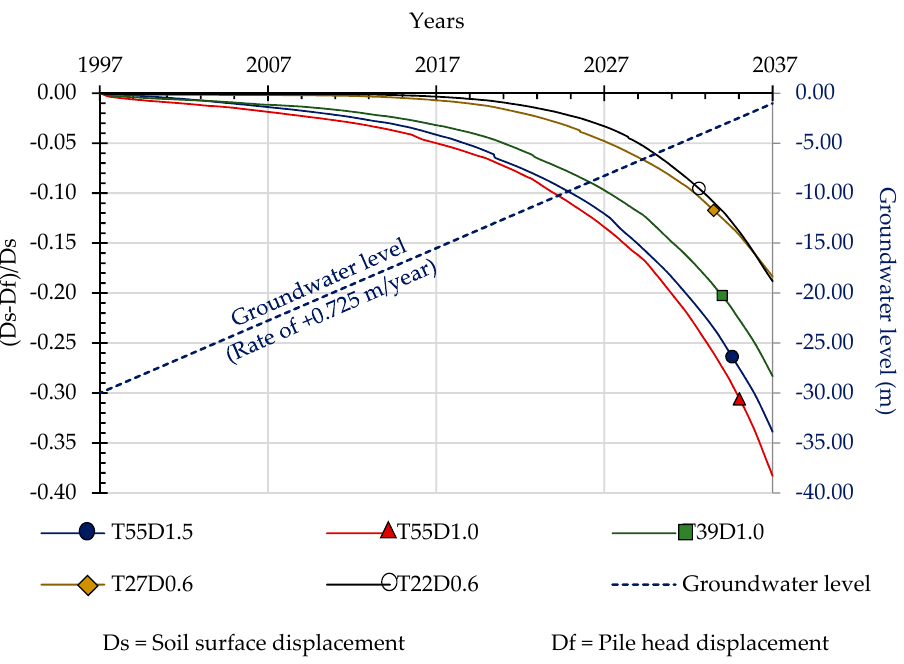
Figure 9. Normalized displacements relative to the groundwater level vs. time.